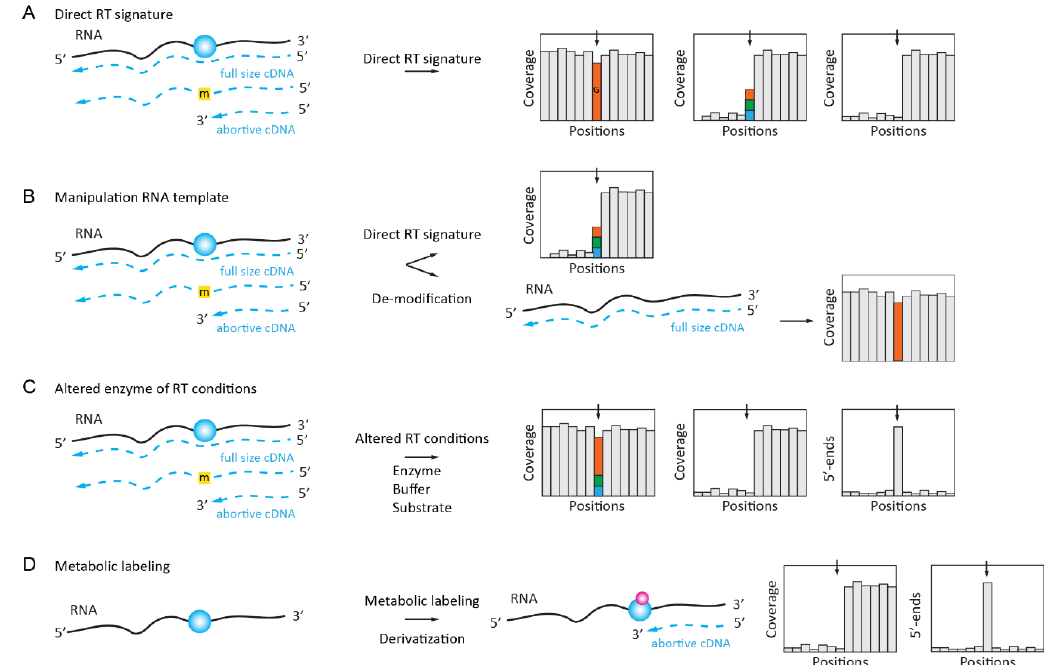
Figure 1. Direct detection of RNA modifications by natural or induced reverse-transcription (RT) signatures. ( A ): natural abortive/mutational RT signatures formed in cDNA. The signature may be seen as a pure mutation (different nucleotides are shown by color), a combination of abortive cDNA synthesis with mis-incorporation, or as a simple abortive cDNA synthesis. ( B ): reverse transcription signature is altered after the de-modification of RNA template. ( C ): RT signature is induced by specific RT conditions (buffer, substrate concentration), by altered deoxynucleotide triphosphates (dNTP), or by a mutation in the RT active site. ( D ): RT signature induced by metabolically labeled RNA-modified nucleotide (applied to RNA methylations with SAM analog).